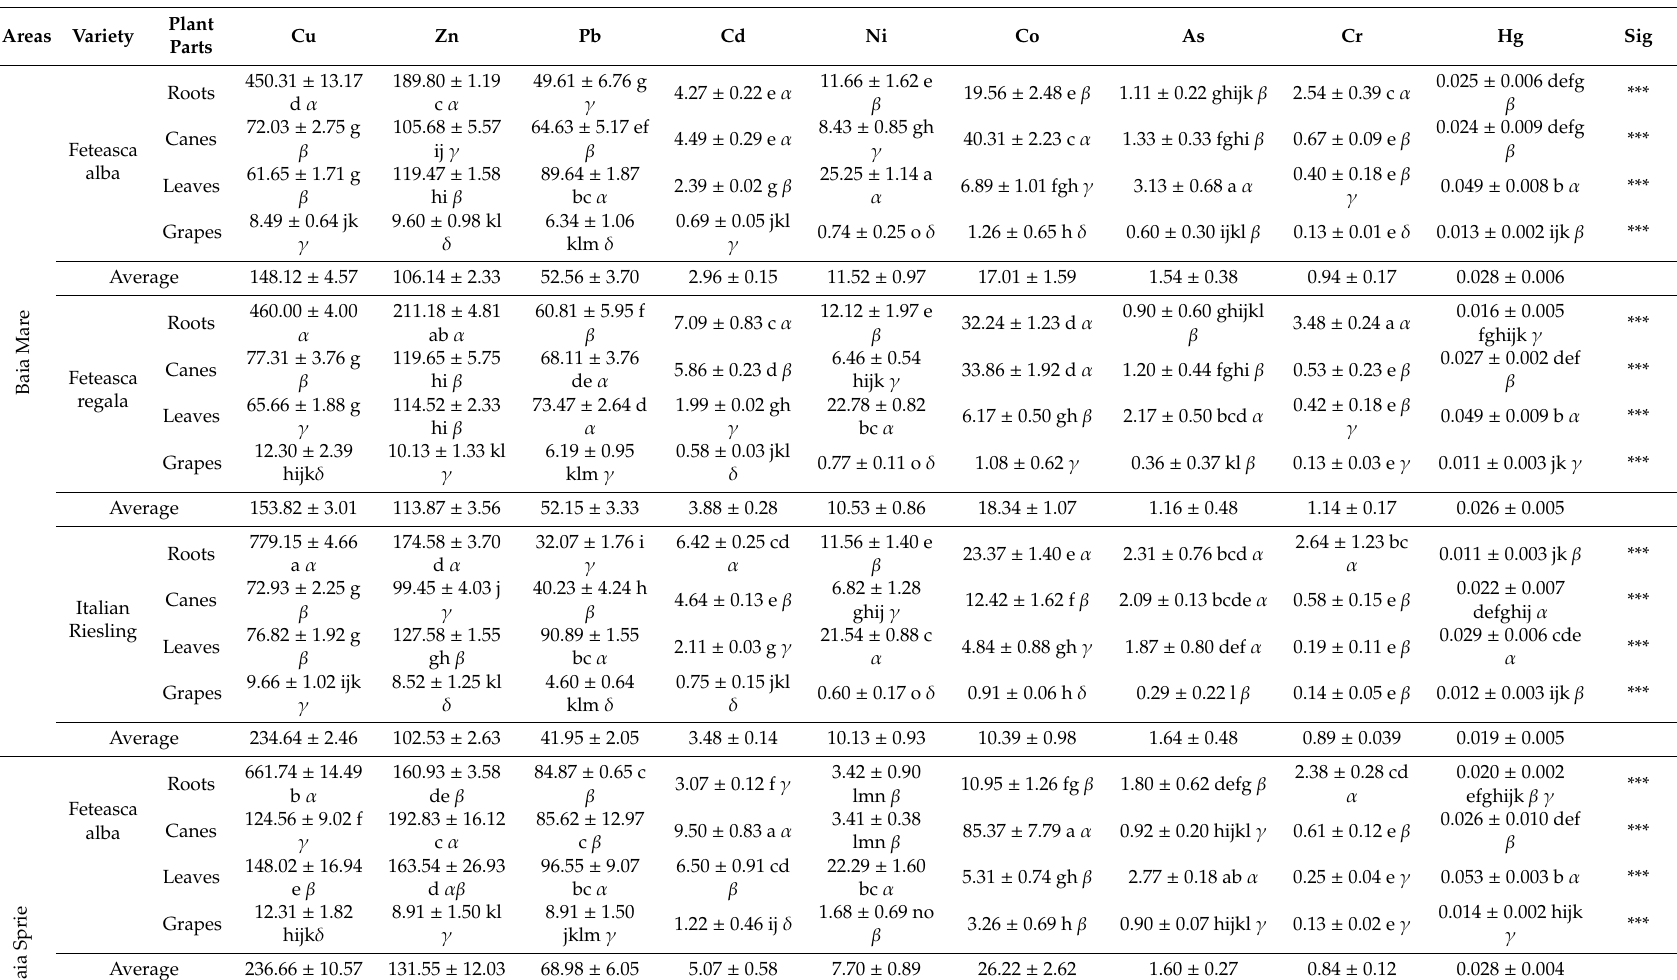
Table 2. The content of heavy metals in plant samples (mg / kg DW)(Mean ± standard deviation) ( n = 3). Areas